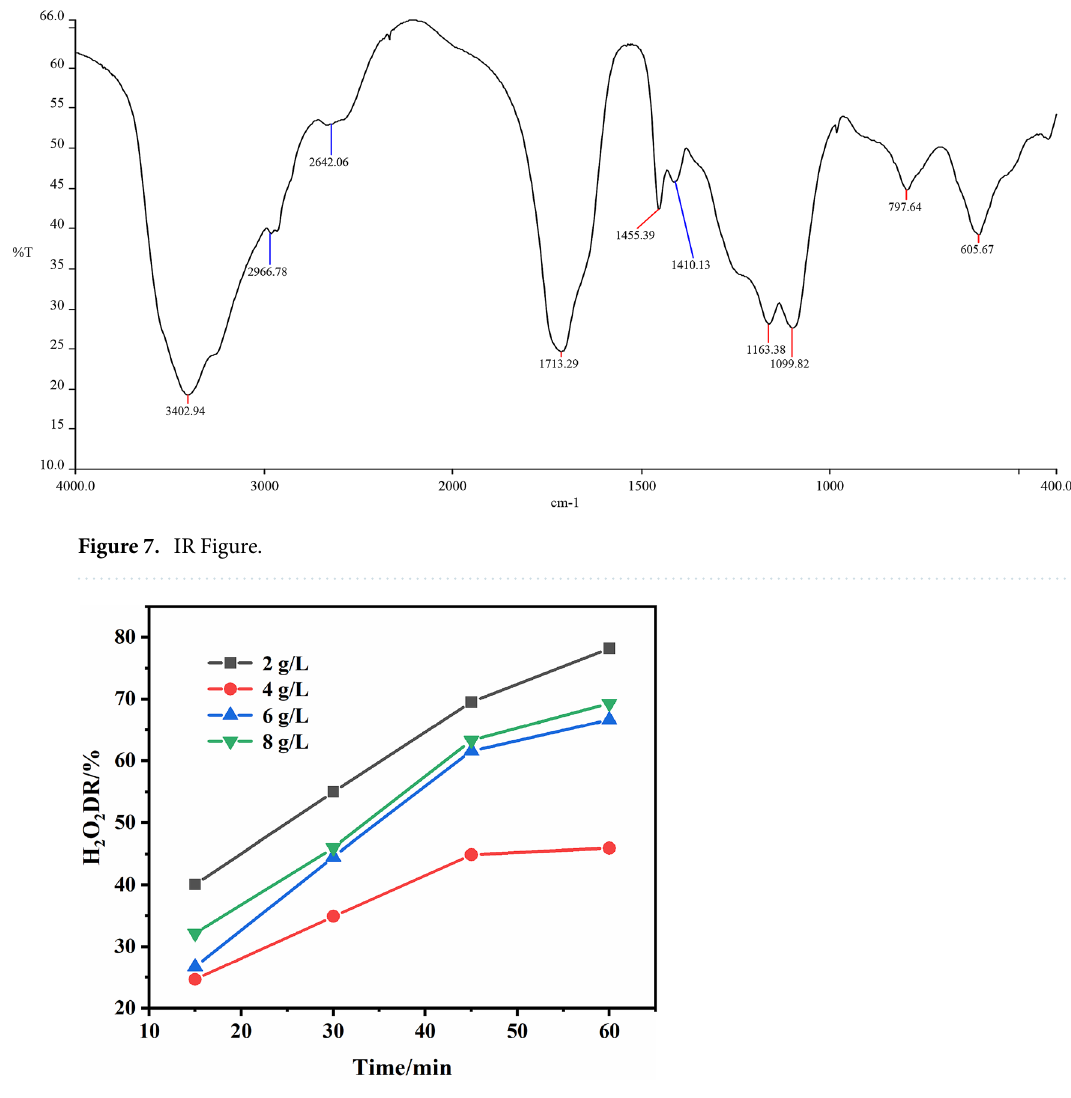
Figure 8. Effect of the synthesized stabilizer on H 2 O 2 decomposition